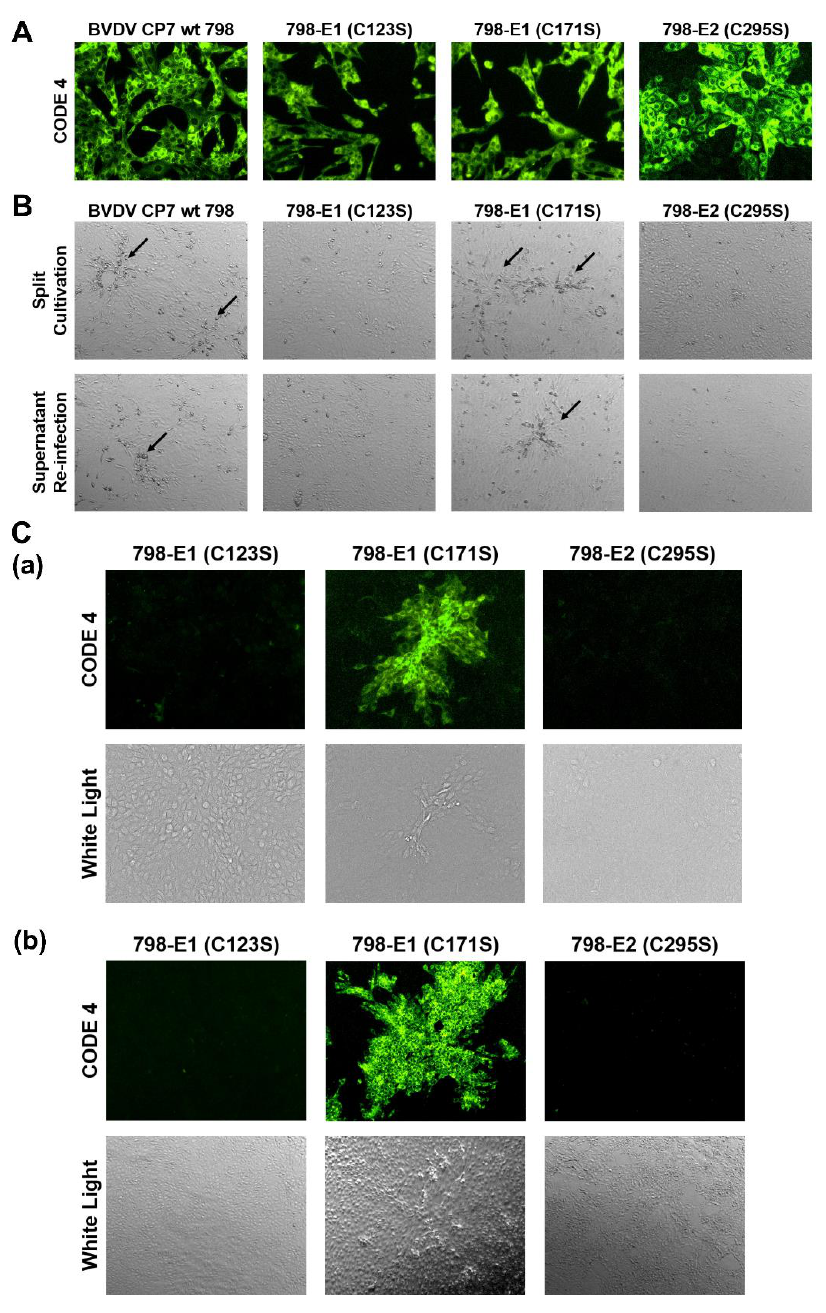
Figure 6. Effect of Cys mutations in E1 and E2 on recovery of infectious BVDV. ( A ) MDBK-B2 cells were first transfected by electroporation with the RNAs transcribed from the given plasmids. One day after EP, the cells were fixed with 4% PFA and permeabilized with 0.05% Triton X-100. The viral protein NS3 was detected with the primary antibody Code 4 and α-mouse FITC. ( B ) CPE observation after split of electroporated cells (upper row) or freeze/thaw extract infection of fresh cells (lower row). Arrows point at areas with rounded cells that show the beginning of a cytopathic effect ( C ) Analysis of cells split after electroporation ( a ) or of fresh cells infected with the supernatant (SN) of electroporated cells ( b ). The cells were fixed with 4% PFA and permeabilized with 0.05% Triton X-100. The viral protein NS3 was detected with mAb Code 4 (mAb 8.12.7 [37]) against NS3 and α-mouse FITC. Magnification 100×.